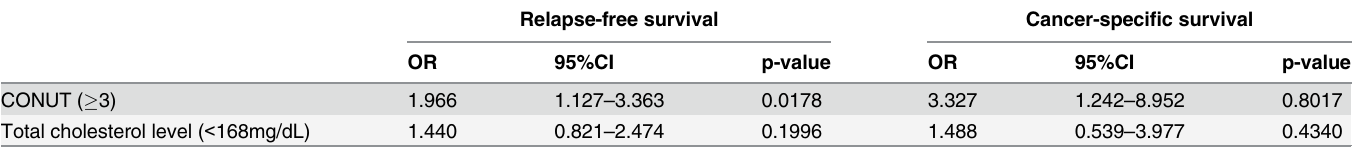
Table 8. The results of the multivariate analysis of the association between the CONUT score and the total cholesterol level with relapse-free sur- vival and cancer-specific survival.